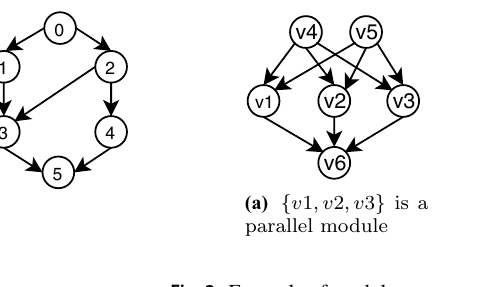
Fig. 2b, the vertices v 1, v 2, v 3 form a linear module. Note, how-